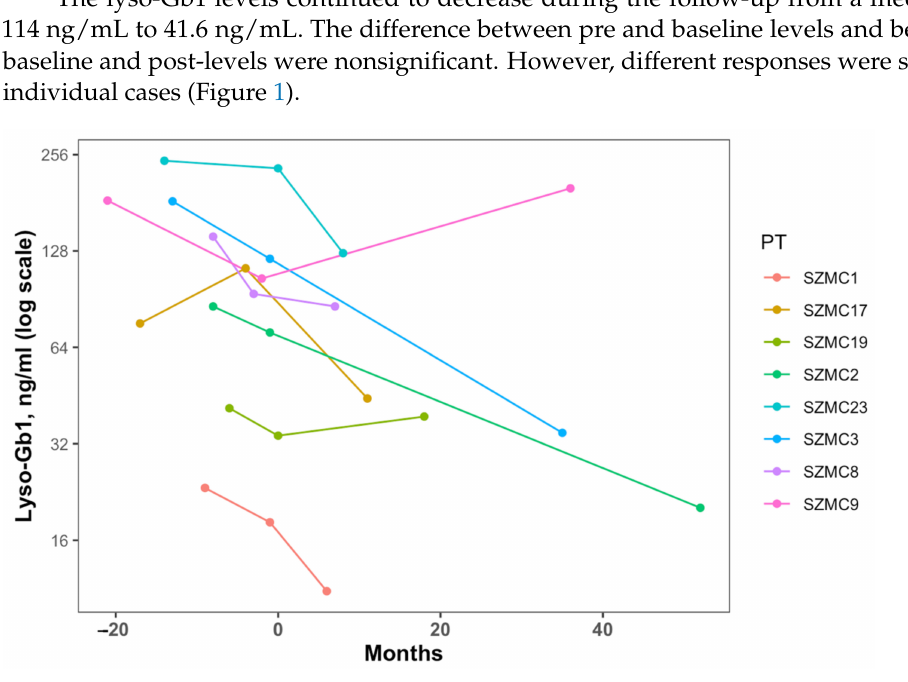
Figure 1. Change over time in lyso-Gb1 levels. Time 0 is the time of the